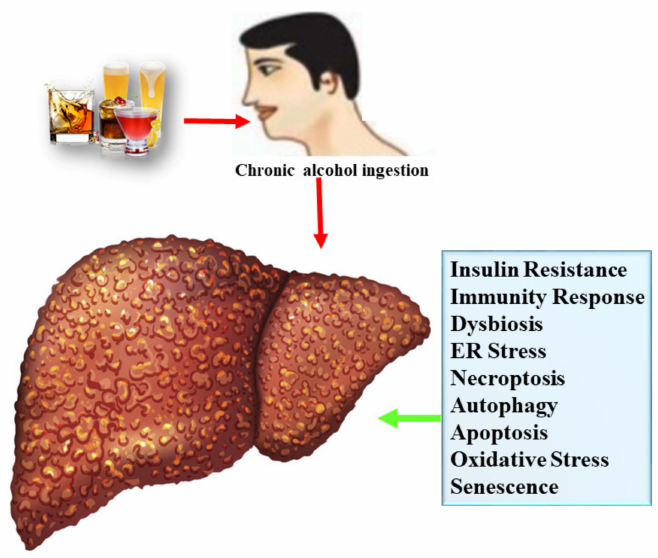
Figure 2. The spectrum and pathogenesis of